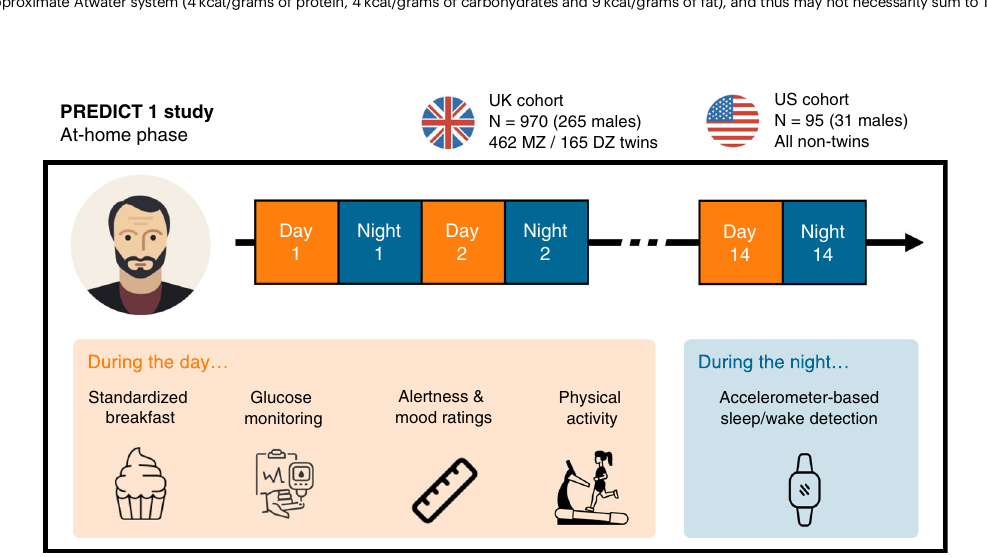
physical activity during the day. The continuous glucose monitor was used to measure postprandial glucose response. Participants also recorded their dietary intake,satiety,mood,andexerciseonthestudyappthroughoutthestudy.Theapp also prompted participants to report their alertness levels on a 0 – 100 visual ana- logue scale at t=0minutes (time of logging of a meal) and regular intervals fol- lowingtheloggingofameal(see “ Methods ” ).SourcedataareprovidedasaSource Data fi le.Thecupcakeicon,therulericonandthesmartwatchiconwerepurchased anddownloadedfromthenounproject.com.Allothericonswerepurchasedand/or downloaded from icon fi nder.com. MZ monozygotic, DZ